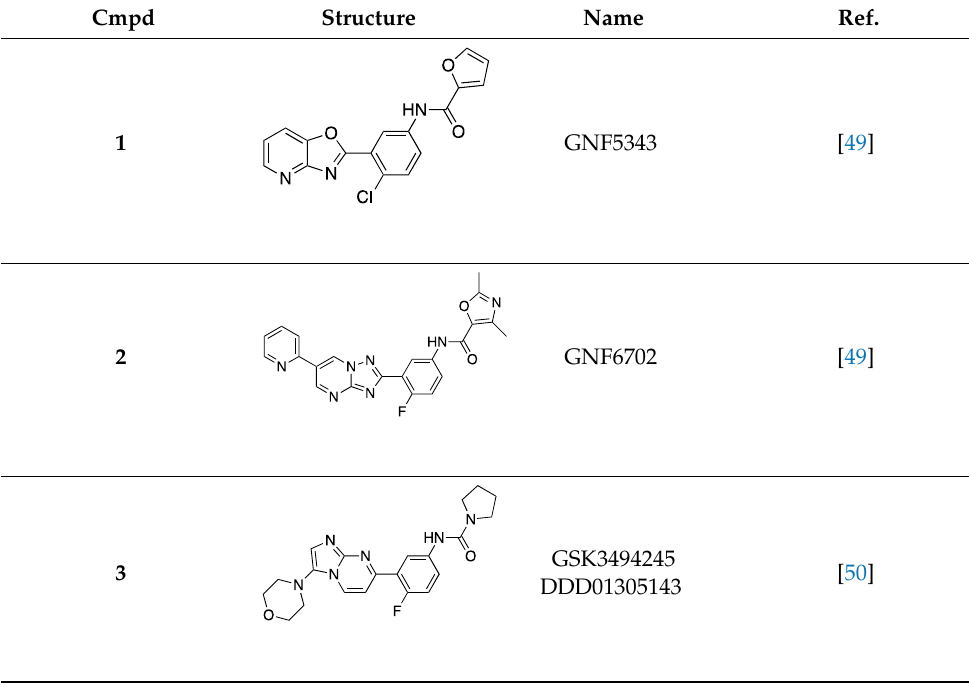
Table 2. Kinetoplastid proteasome inhibitors.